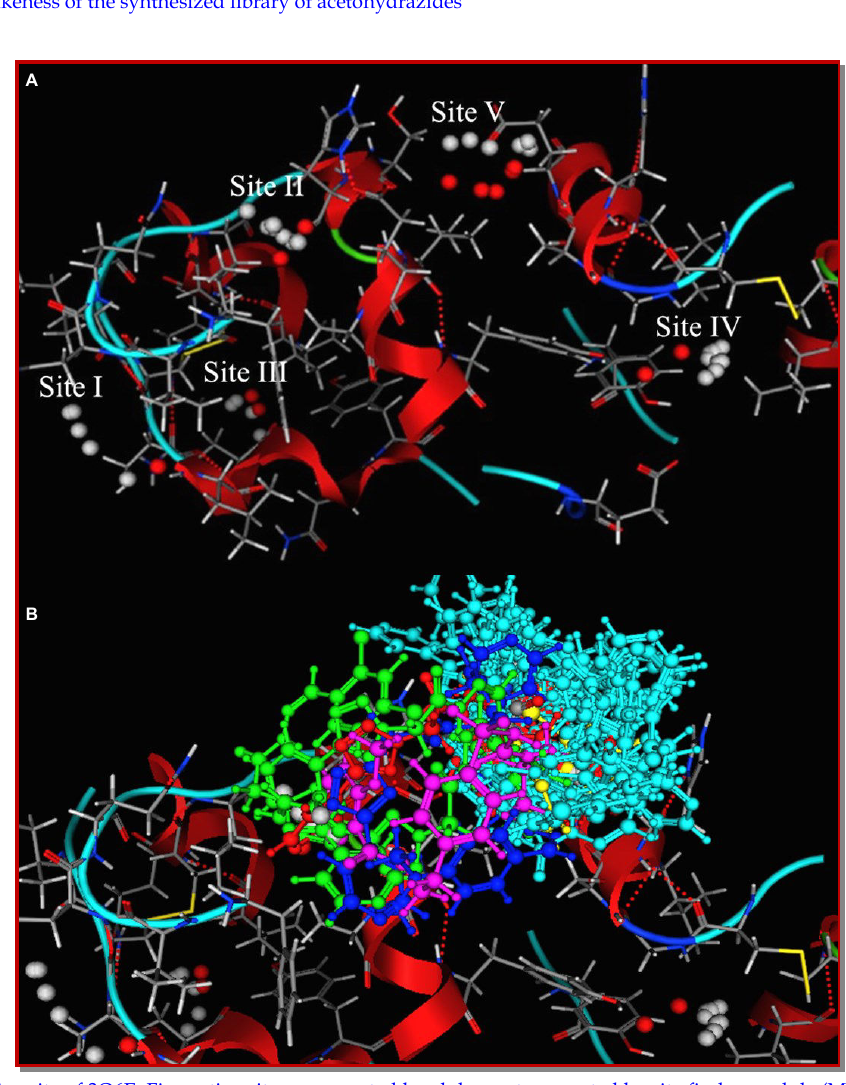
Figure 3: A) Active site of 3Q6E. Five active sites represented by alpha centers created by site finder module (MOE). B) Active site of human insulin protein (3Q6E). Docked poses of all the most favorable docked conformations of the ligands are shown inside the pocket. Ligands are presented in ball n stick mode while key amino acid residues are shown in elemental color, stick mode. Back- bone receptor is presented in cartoon and ribbon form. Active sites are marked with grey and red colored spheres